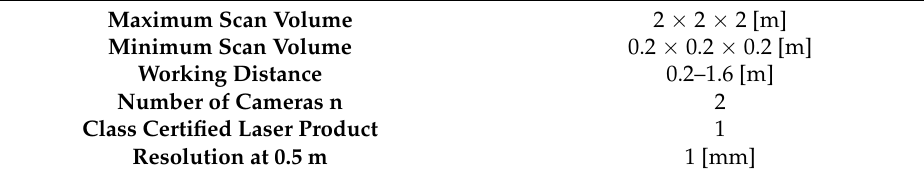
Table 2. Technical specifications of Sense™ 3D